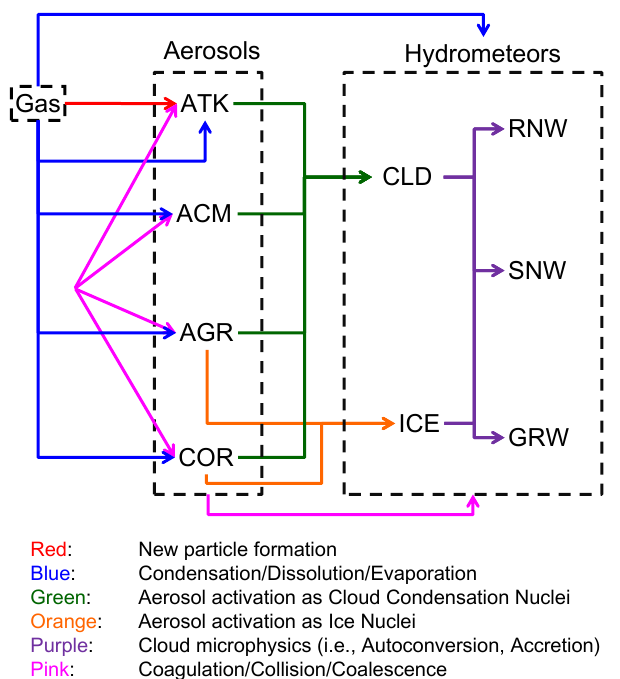
Fig. 2. Schematic illustration of gas-aerosol-cloud dynamic pro- cesses based on the categorical approach of RAQM2